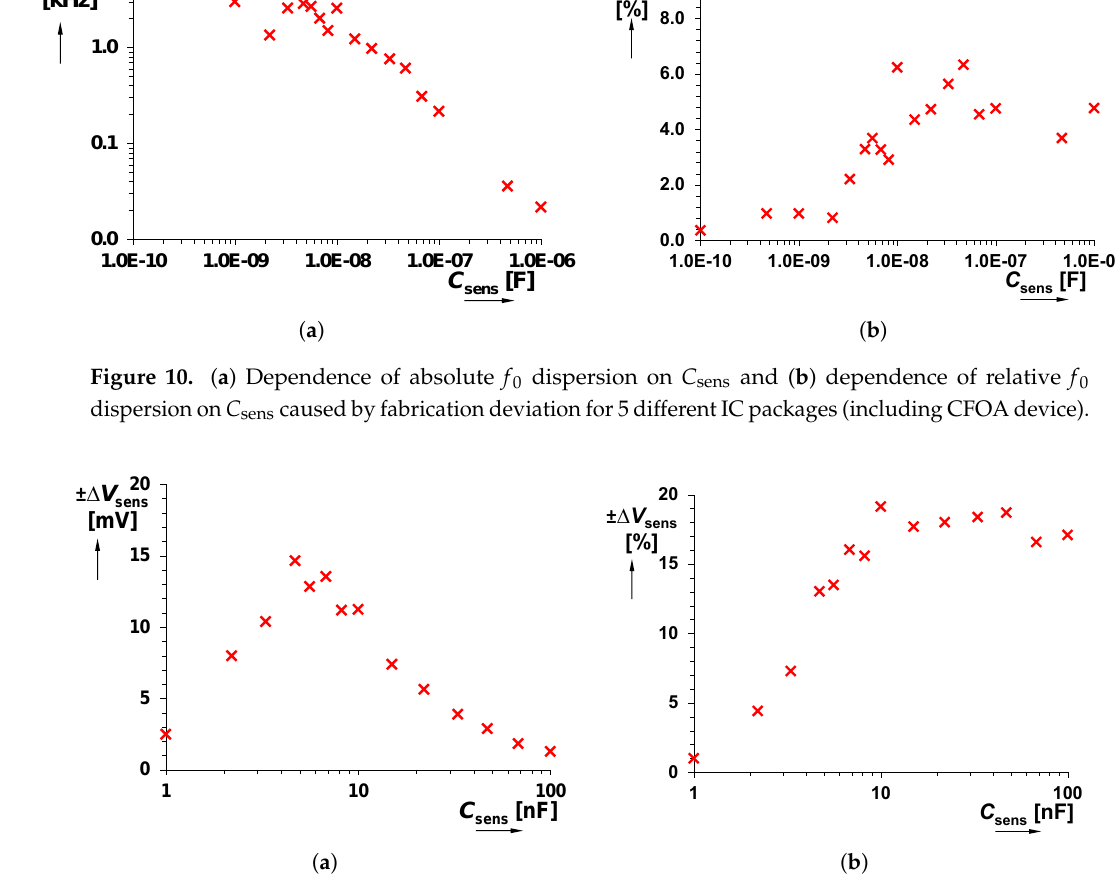
Figure 11. ( a ) Dependence of absolute V sens dispersion on C sens and ( b ) dependence of relative V sens dispersion on C sens caused by fabrication deviation for 5 different IC packages (including CFOA device).